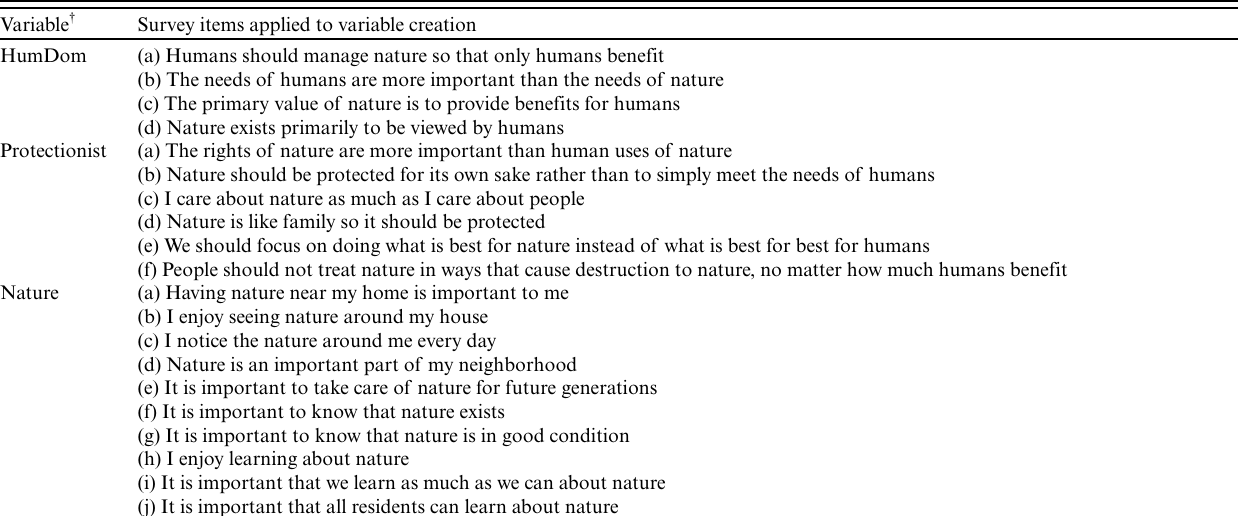
Table 3 . Derivation of value orientations